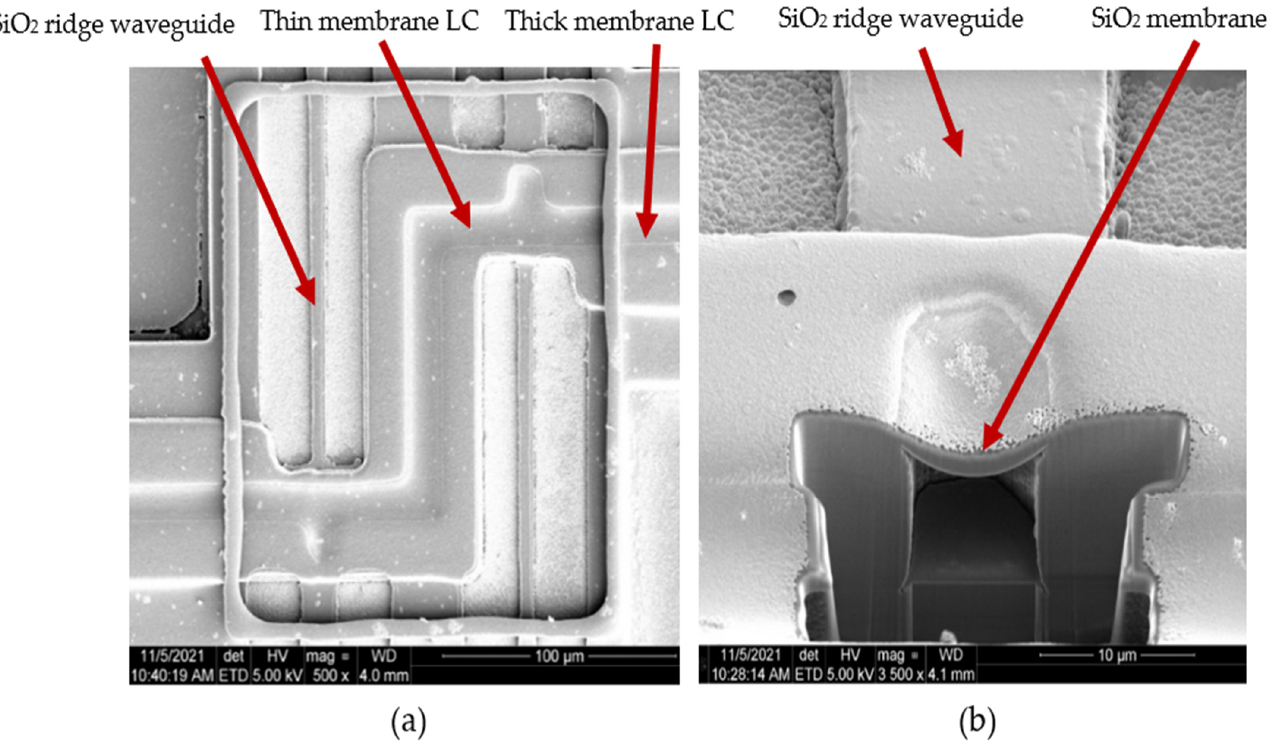
Figure 5 . ( a ) Top view image of a scanning electron micrograph (SEM) of the thin membrane optofluidic region. ( b ) Profile of the protrusion cavity using focused ion beam milling (FIB). FIB backfilling accounts for increased thickness of the membrane in this image.